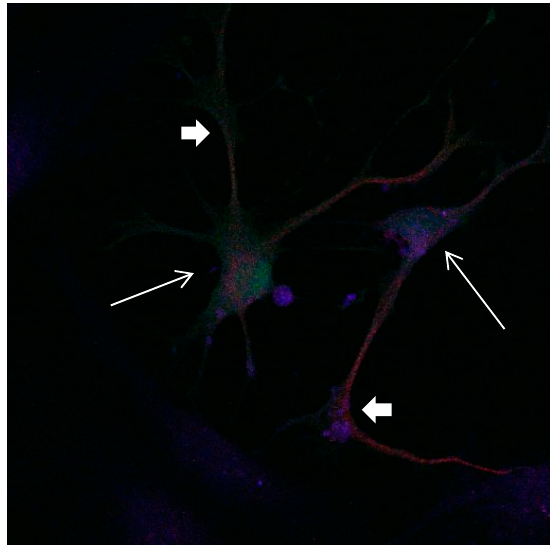
Figure 7. Cultures in a serum-free medium, 5 days (6 days after the passage): Immunofluorescence with anti-GFAP (glial fibrillary acidic protein) (red, secondary antibody: donkey anti-goat IgG Alexa Fluor 594), and with anti-Calbindin D28k (polyclonal antibody from the company SWANT) (green, secondary antibody: donkey anti-rabbit IgG Alexa Fluor 488); Nuclear staining with DAPI (4 ′ ,6-diamidino-2-phenylindole dihydrochloride) (blue). Confocal microscopy. Zoom = 4, 2 Calbindin D28k positive and GFAP-positive astrocytes (long arrows) with processes (short arrows).